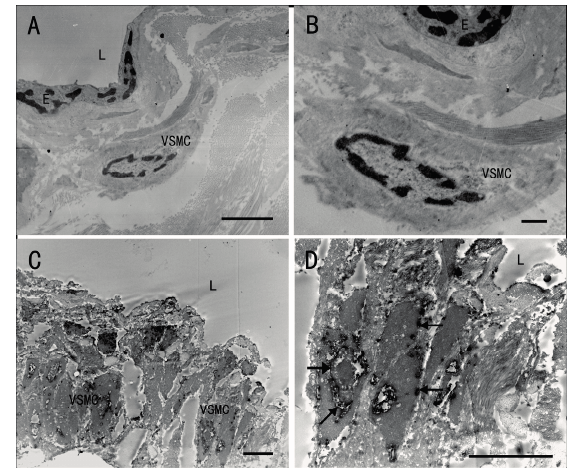
Figure 4. Expression of OPN and integrin β 3 as detected by TEM. Normal vein with rare positive OPN ( A , B ) or integrin β 3 ( E , F ) electron-dense black granules in VSMC. Varicose veins with OPN electron-dense black granules ( C , D ) located on the nuclear membrane ( → ), rough endoplasmic reticulum ( ↗ ) and cytomembrane ( ← ) of intimal VSMC. Varicose veins with integrin β 3 electron-dense black granules ( G , H ) located on the cytomembrane ( ↓ ) of intimal VSMC. Lumen (L). Endothelial cell (E). Scale bar = 5 μ